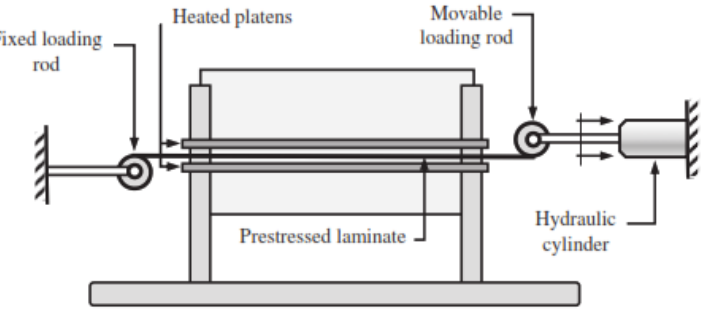
Figure 10. Schematic representation of the hydraulic prestressing rig [46].